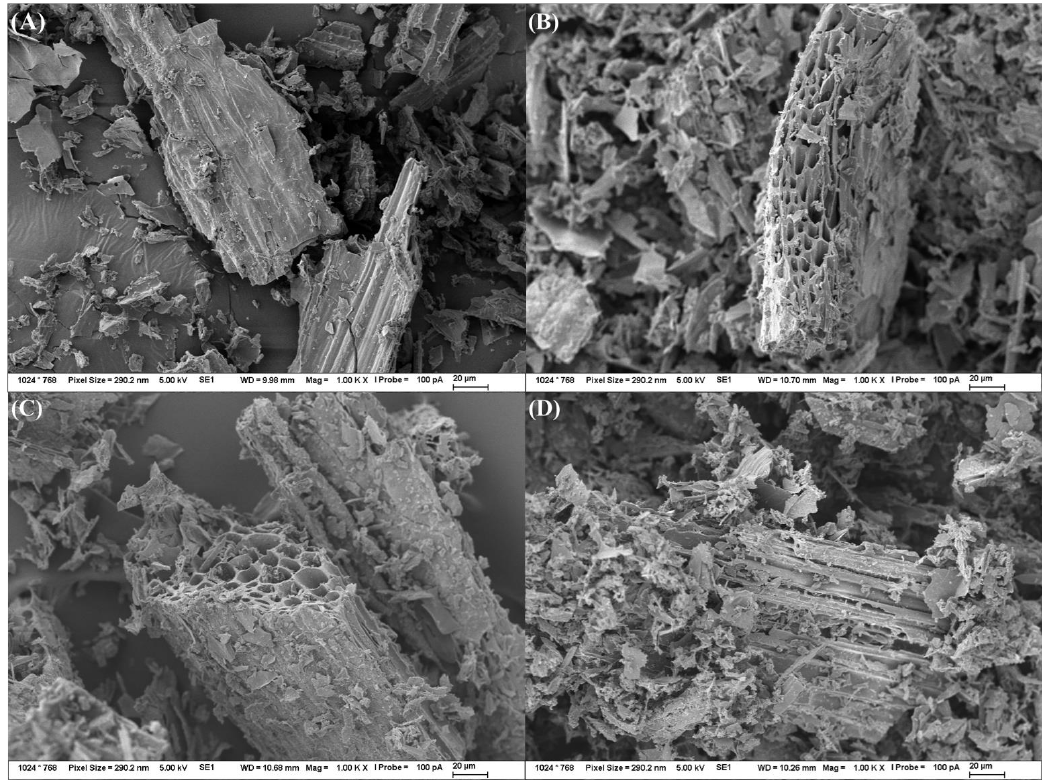
Figure 3. SEM visualization (magnification 1000×) of the pyrolysis temperature effect (residence time 60 min) on the morphology of produced biochar originating from corn residual biomass — ( A ) 400 ◦ C; ( B ) 500 ◦ C; ( C ) 600 ◦ C; ( D ) 700 ◦